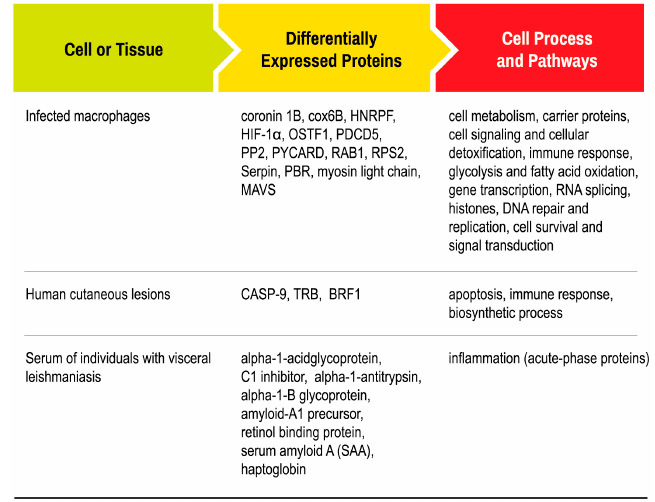
Figure 3. Proteins involved in the host response to Leishmania infection. Proteins identified as differently expressed in Leishmania infected host in proteomics studies.